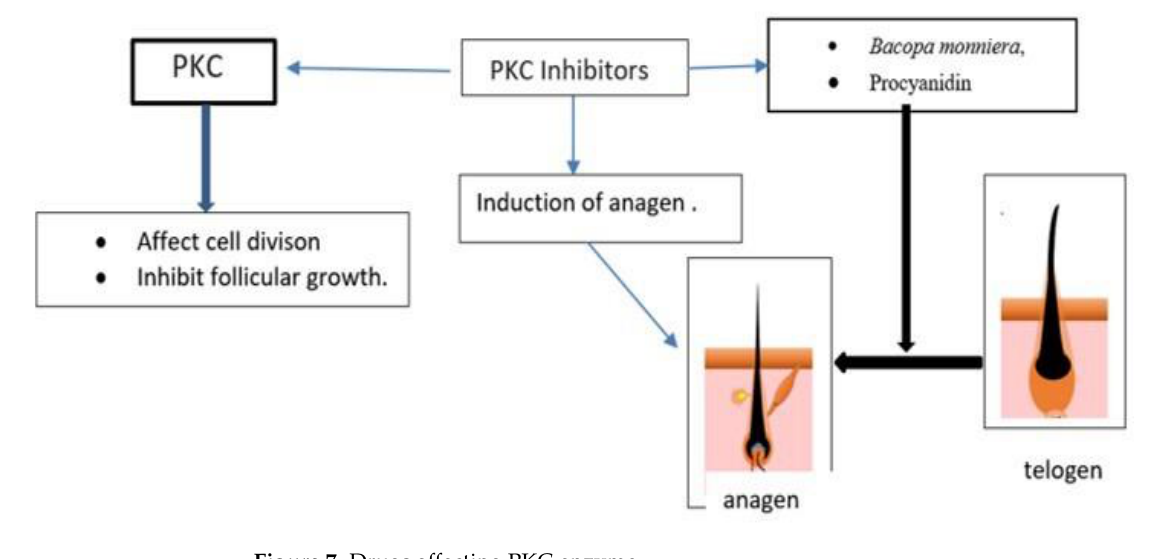
Figure 7. Drugs affecting PKC enzyme. As shown in the Table 6. Procyanidin B-2 is a proanthocyanidin. Procyanidin B-2 is found in Chinchona , Ceylon cinnamon, apple, Crataegus monogyna , Uncaria guianensis , and Vitis vinifera . It is reported that Procyanidin B is in Bacopa monniera , a perennial plant belonging to the Plantaginaceae family. The extract of Bacopa monniera acts by inhibiting protein kinase C (PKC). The extract causes the enlargement of the follicle, prolongation of anagen phase duration, and prevents hair loss [106]. Table 6. Herbal drugs acting on PKC